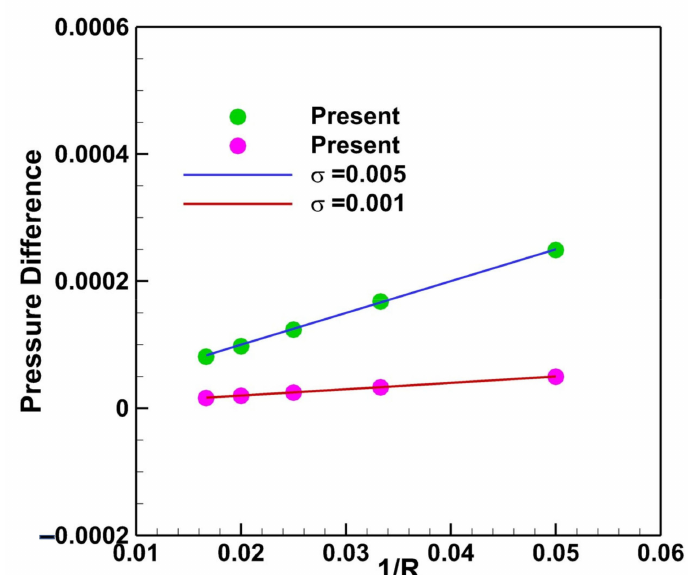
Figure 4. Pressure difference inside and outside the bubble at σ = 0.001 and 0.005.